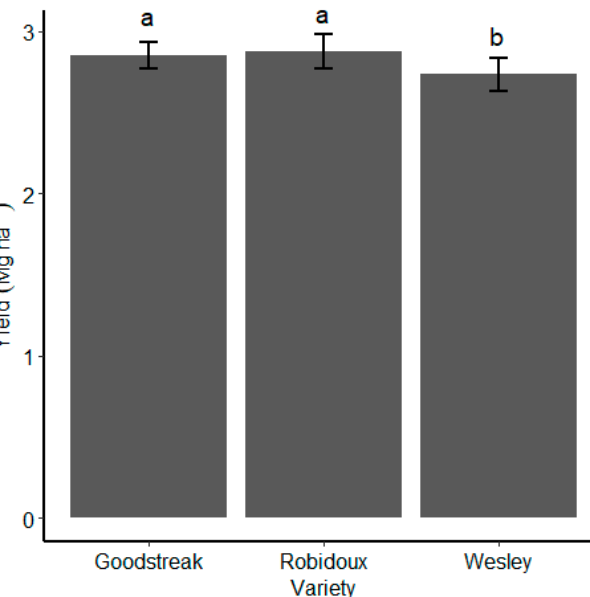
Figure 3. Grain yield at Sidney experimental site as affected by variety grown in 2018 and 2019. The error bars represent the standard error of the mean. Different letters on top of column bars indicate a significant mean difference at p < 0.05.